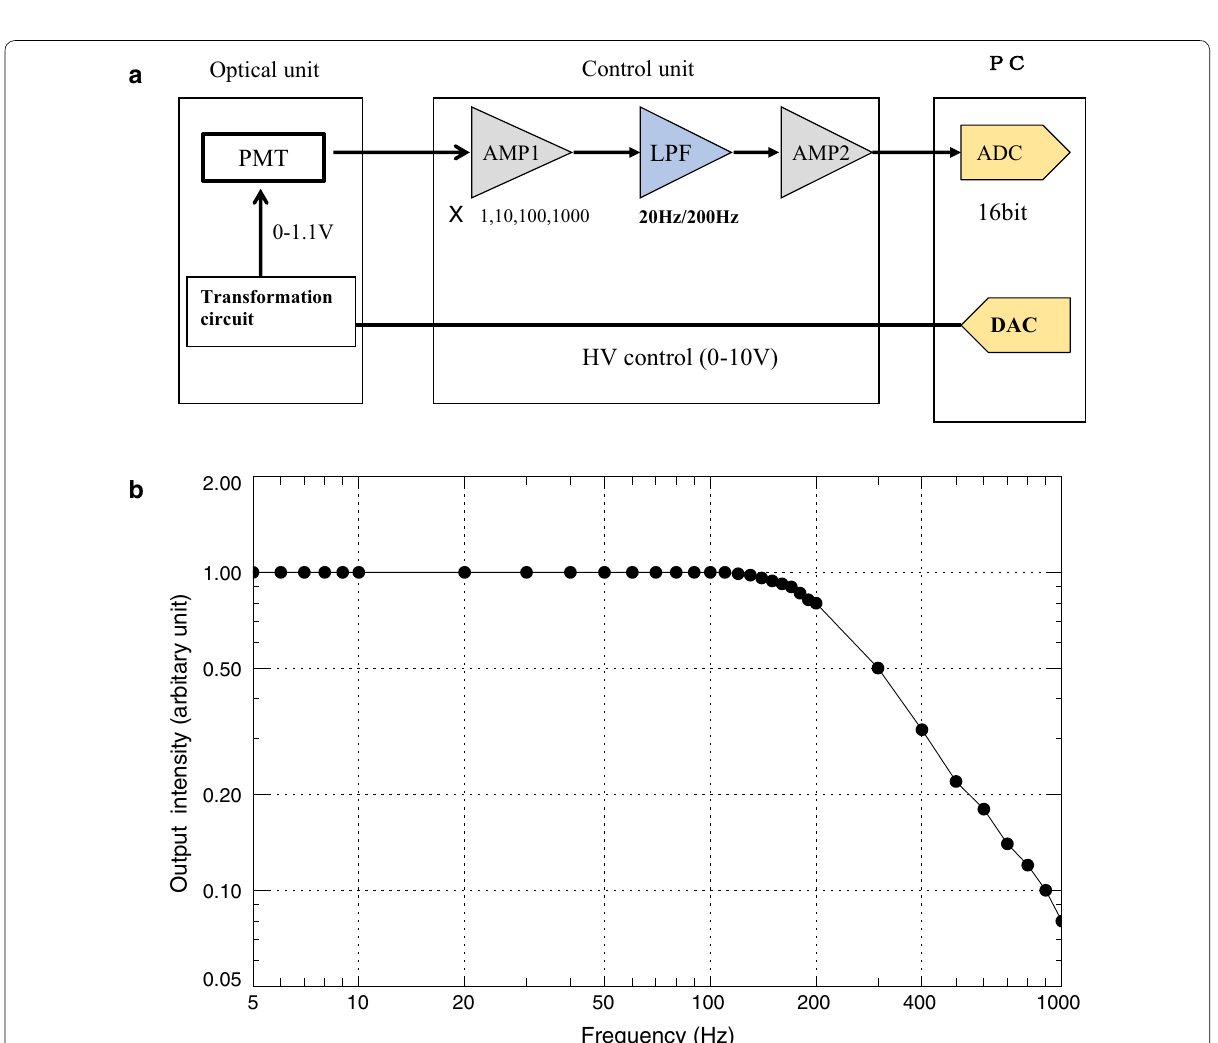
Fig. 4 a Schematic diagram of the signal processing in the optical unit, control unit, and PC. b Response of the control unit (Ch1) with a low-pass filter of 200 Hz as function of frequency. Output intensity is